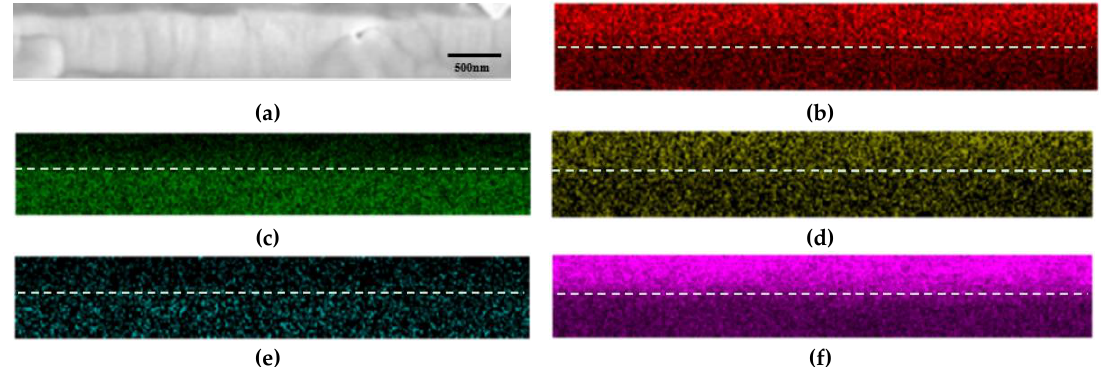
Figure 11. Cross-sectional mapping of TP347HFG at 700 °C. ( a ) SEM figure; ( b ) Cr; ( c ) Fe; ( d ) Mn; ( e ) Ni; ( f ) O.